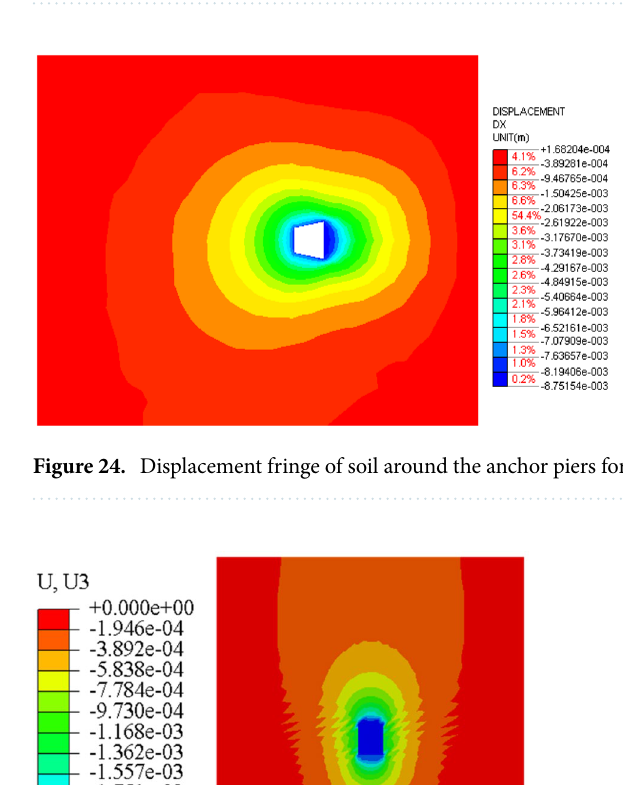
Figure 23. Displacement fringe of soil around the anchor piers for 100 kN.